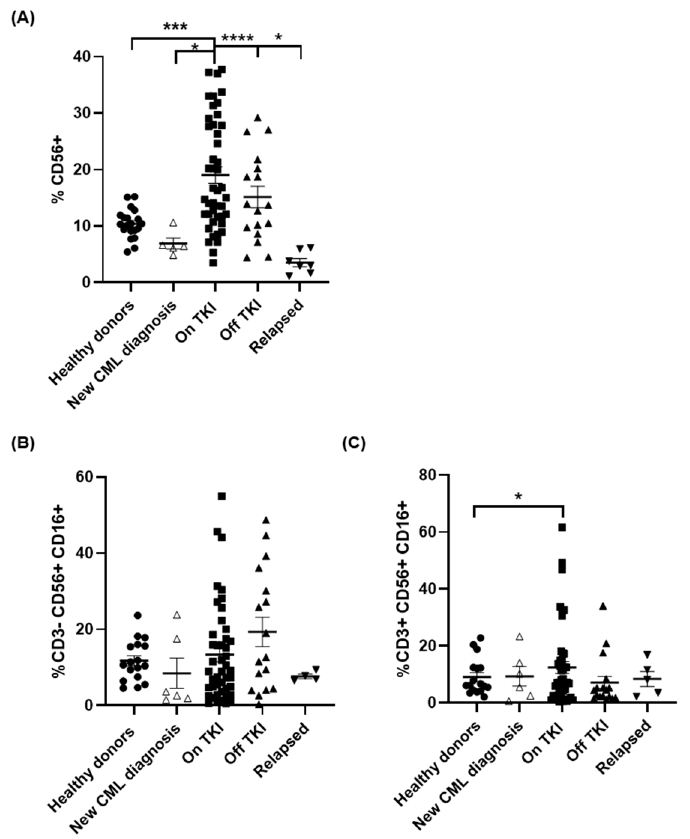
Figure 1. Decrease in Natural Killer (NK) cell populations in peripheral blood of patients with CML who relapsed after treatment interruption. Analysis by flow cytometry of the expression of total CD56+ cells ( A ), NK cells with profile CD3-CD56 + CD16+ ( B ) and NKT cells with profile CD3 + CD56 + CD16+ ( C ) in peripheral blood from the different groups of patients and healthy donors (Healthy donors ( ● ), new CML diagnosis ( △ ), patients On TKI ( ■ ), patients Off TKI who did not relapse ( ▲ ), patients Off TKI who relapsed ( ▼ )). Each dot corresponds to one sample and lines represent mean ± standard error of the mean (SEM). Statistical significance was calculated using one-way ANOVA and Tukey’s multiple comparisons test. * p < 0.05; *** p < 0.001; **** p < 0.0001.